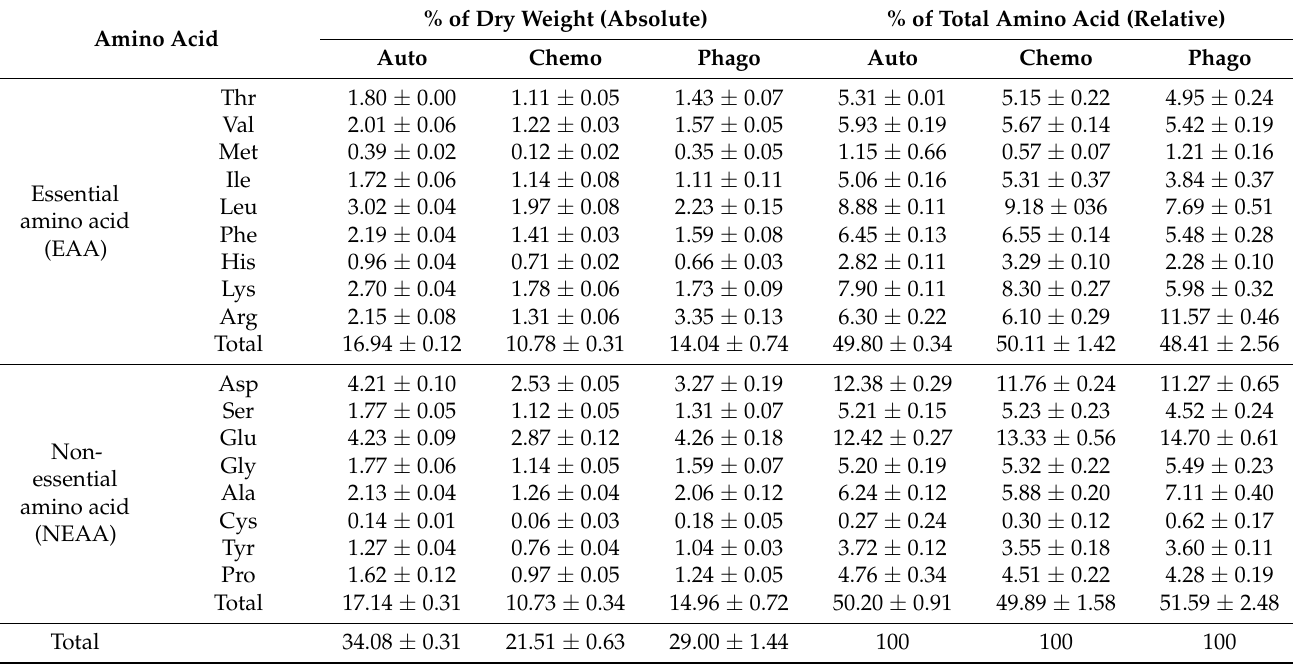
Table 2. Amino acid composition of P. malhamensis with different nutritional modes ( n =